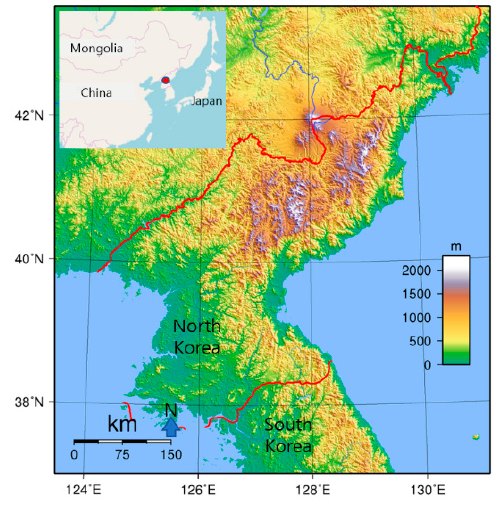
Figure 1. The study area.